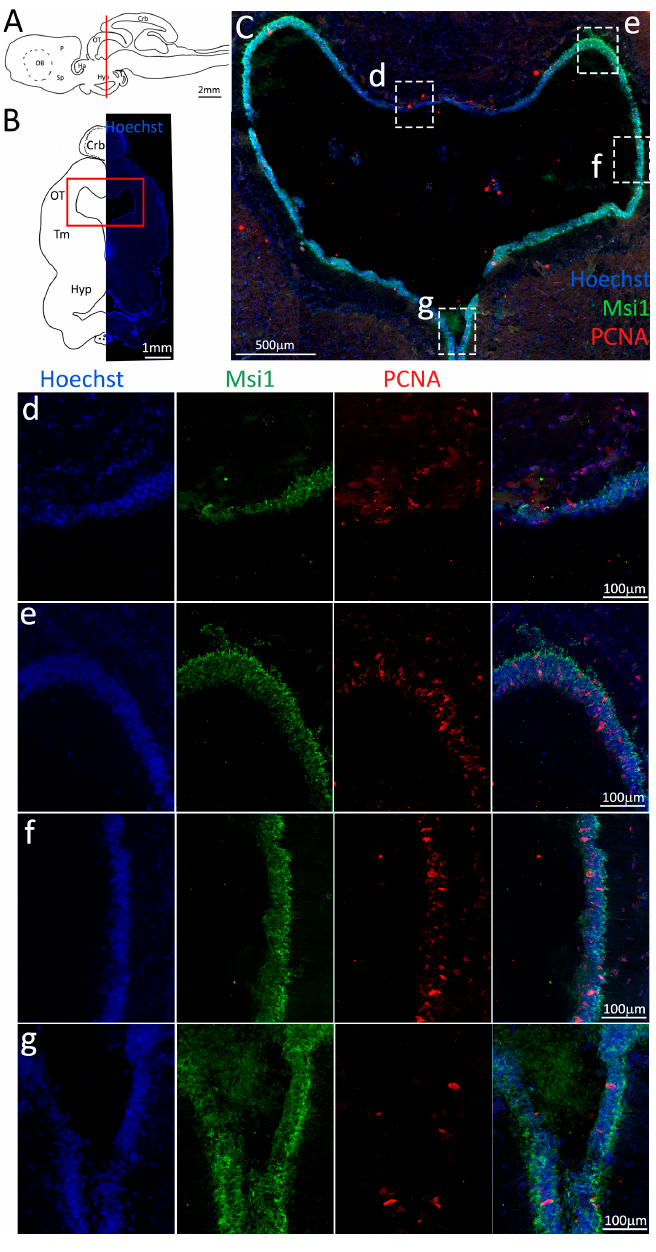
Figure 10. Localization of PCNA (red) and Msi1 (green) positive cells in the mesencephalon of S. canicula . ( A ) Sagittal representation of S. canicula brain. The red line indicates the rostro-caudal localization of the section represented in the panel. ( B ) Coronal map of the area imaged. On the right, a real coronal section is stained with Hoechst 33342 to show nuclei distribution; on the left, a cartoon is drawn to indicate anatomical references. Red rectangle identifies the general area from which images are taken. ( C ) Mesencephalic neurogenic niche. Progenitor cells (Msi1 + , green) are localized around the ventricular wall. ( d , e ) Magnification of the neurogenic niche localized in the tectal region. ( f , g ) Magnification of the neurogenic niche localized in the tegmental area. Abbreviations: